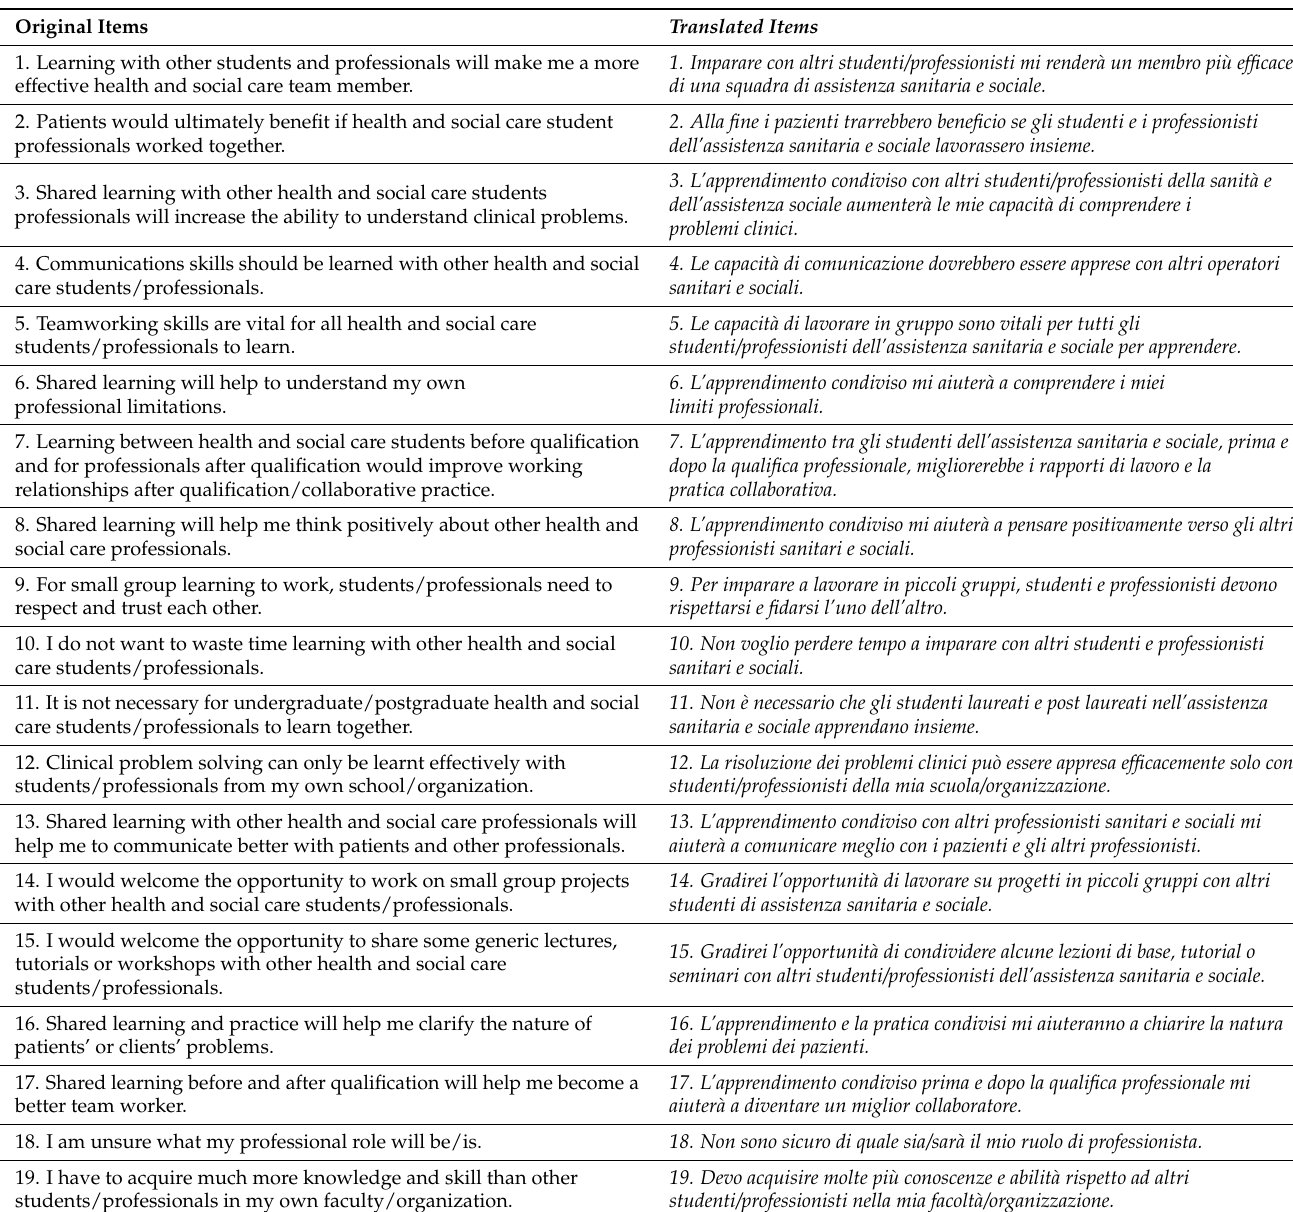
Table 2. Linguistic and cultural adaptation of the RIPLS (final Italian version and last modifications in